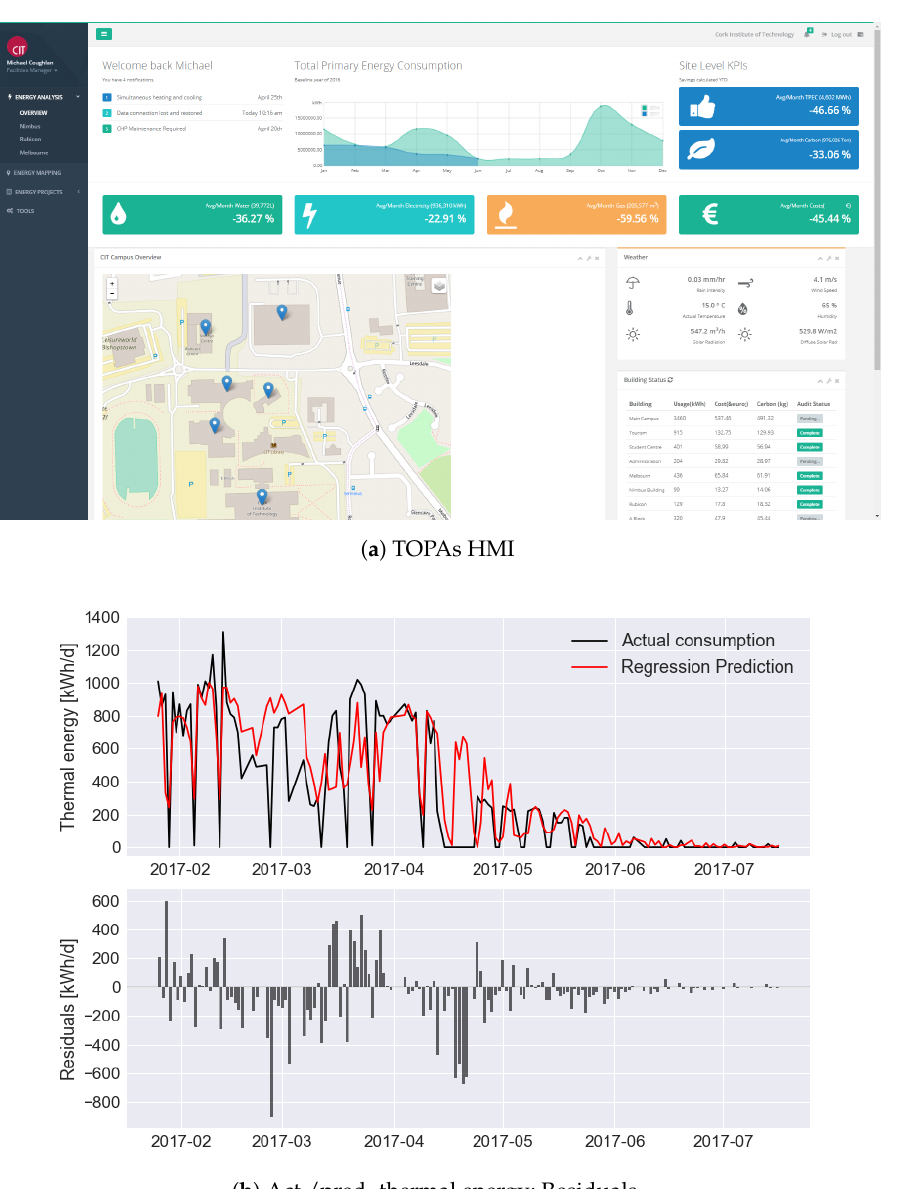
Figure 2. TOPAs HMI and Add-on models